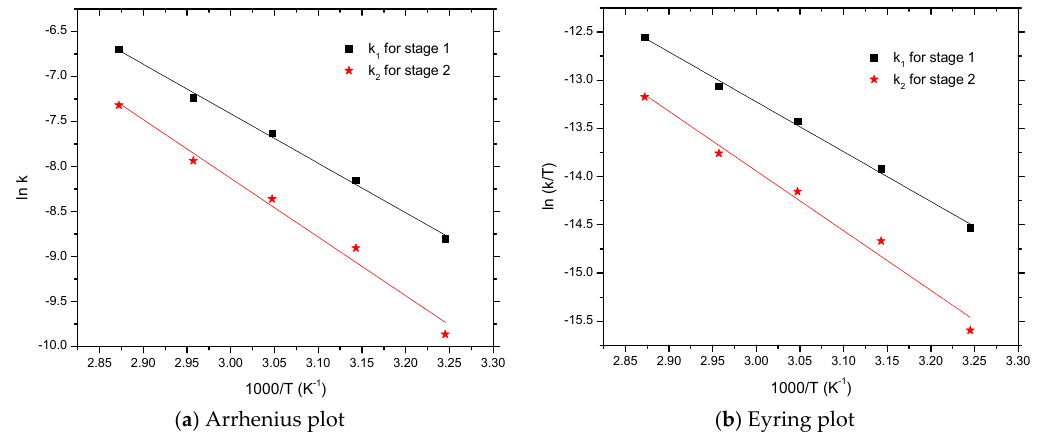
Figure 4. Arrhenius and Eyring plots for the curing reaction between HTPB and IPDI.